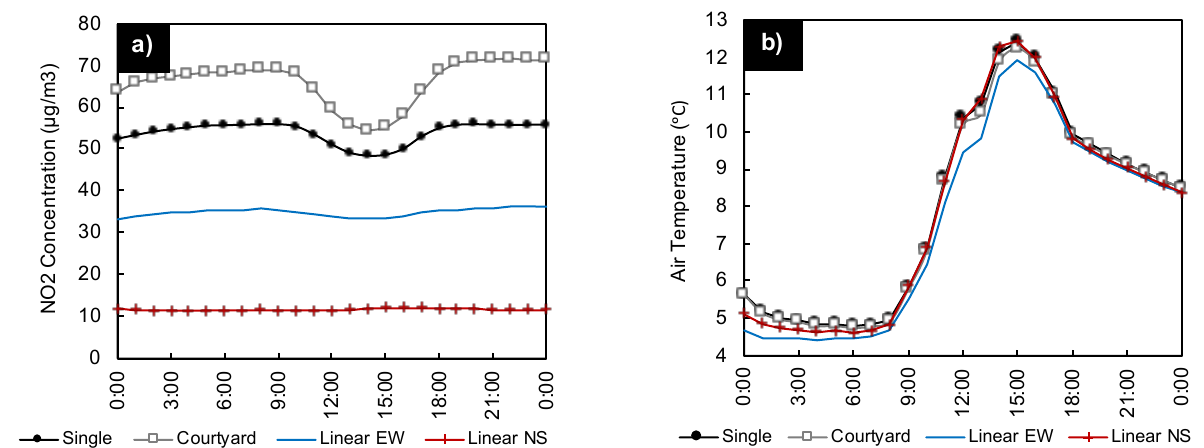
Figure 6. Diurnal NO 2 concentration ( a ) and air temperature ( b ) in the centre of the four scenarios.